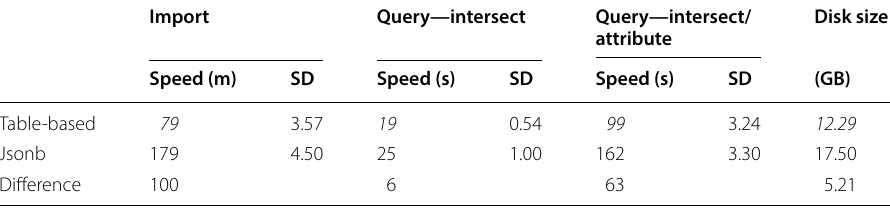
The better results for each metric are emphasized